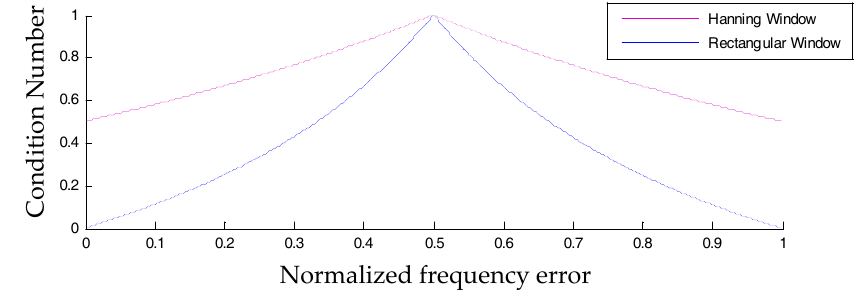
Figure 7. Condition numbers of rectangular window and Hanning window.